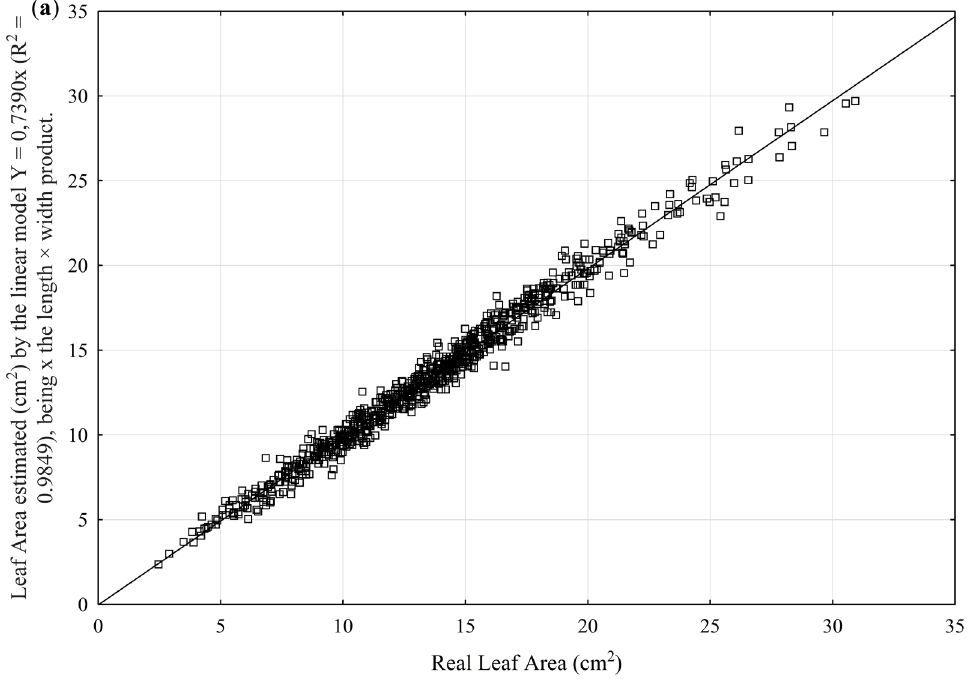
Figure 2a - Relationship of leaf area and leaf area estimated by linear model Ŷ = 0.7390x (R 2 = 0.9849) in 800 leaves of Crotalaria juncea used in the validation, being x the length × width product of each leaf.